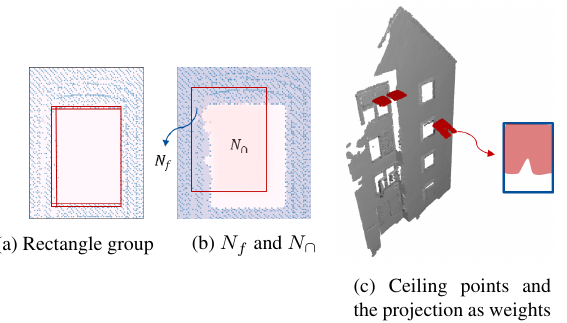
Figure 3. The generation of the window candidates.